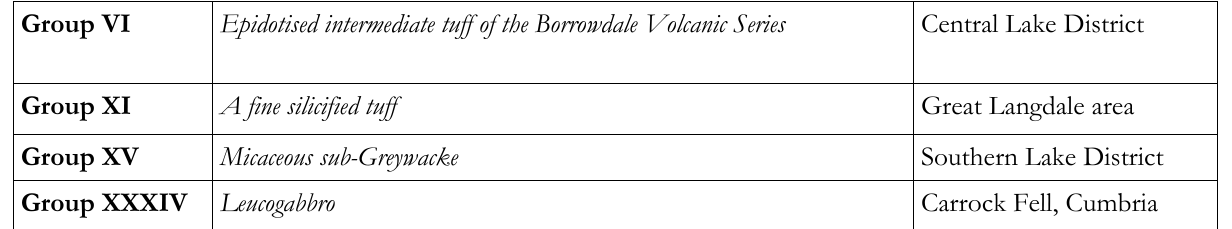
Table 1: Classification of Neolithic stone axes from the North